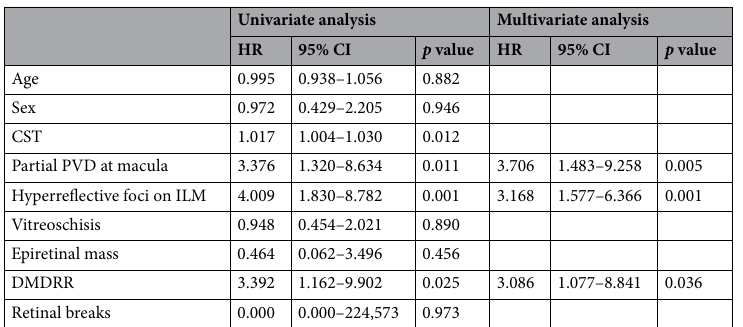
Univariate analysis Multivariate analysis